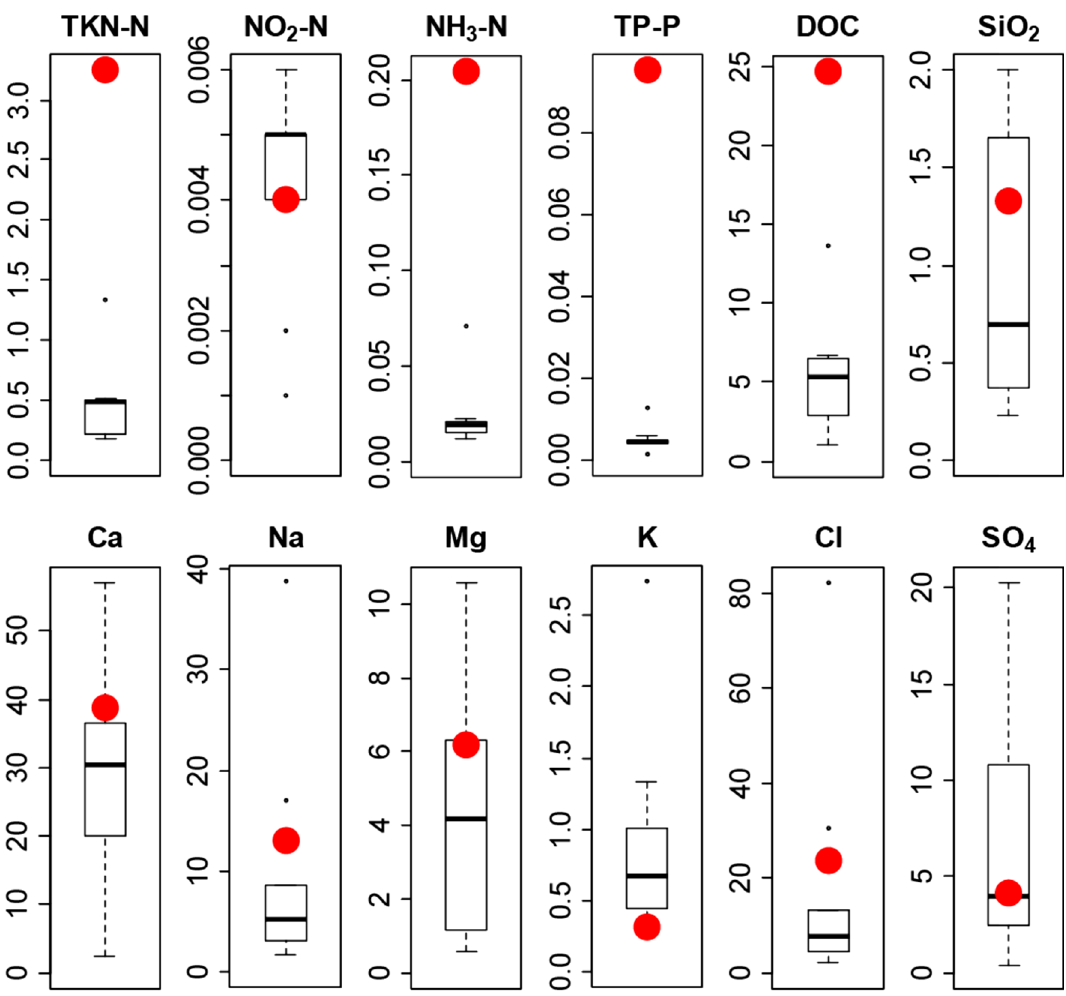
Figure 2. Box and whiskers diagram of water chemistry of nine lakes and ponds sampled on Southampton Island compared to Bung Stick Pond (red circle) (see Fig. 1). Nutrient indicators (top row) and major ion concentrations (bottom row) in mg L −1